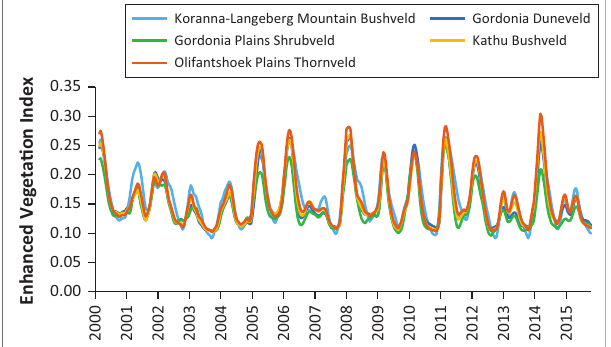
FIGURE 3: Average of smoothed time-series of the Enhanced Vegetation Index using an adaptive Savitzky–Golay filter of TIMESAT for the different vegetation types in the Tswalu Kalahari